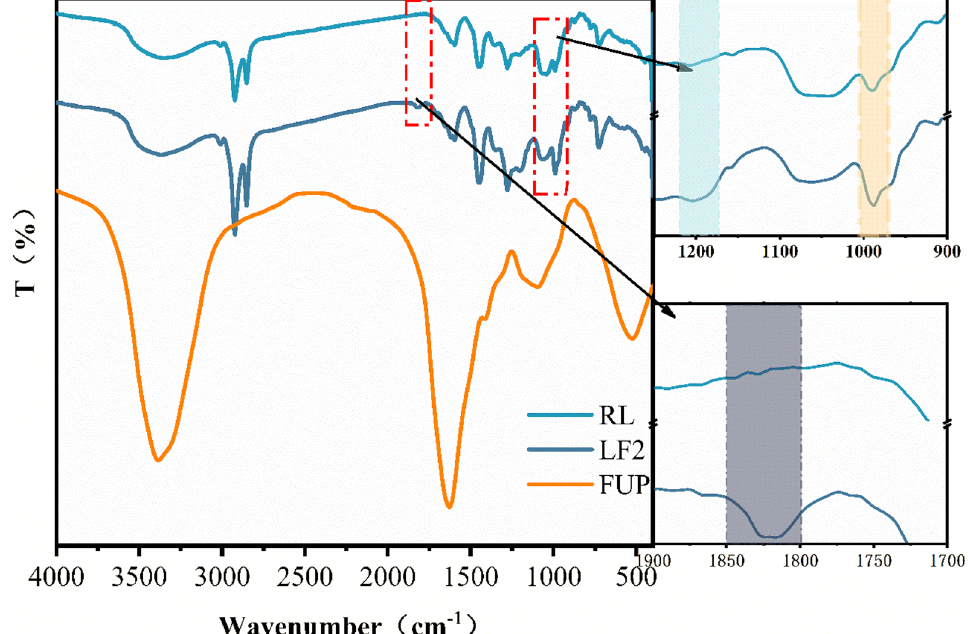
Figure 2. The FT-IR spectra curves of RL, LF2 and